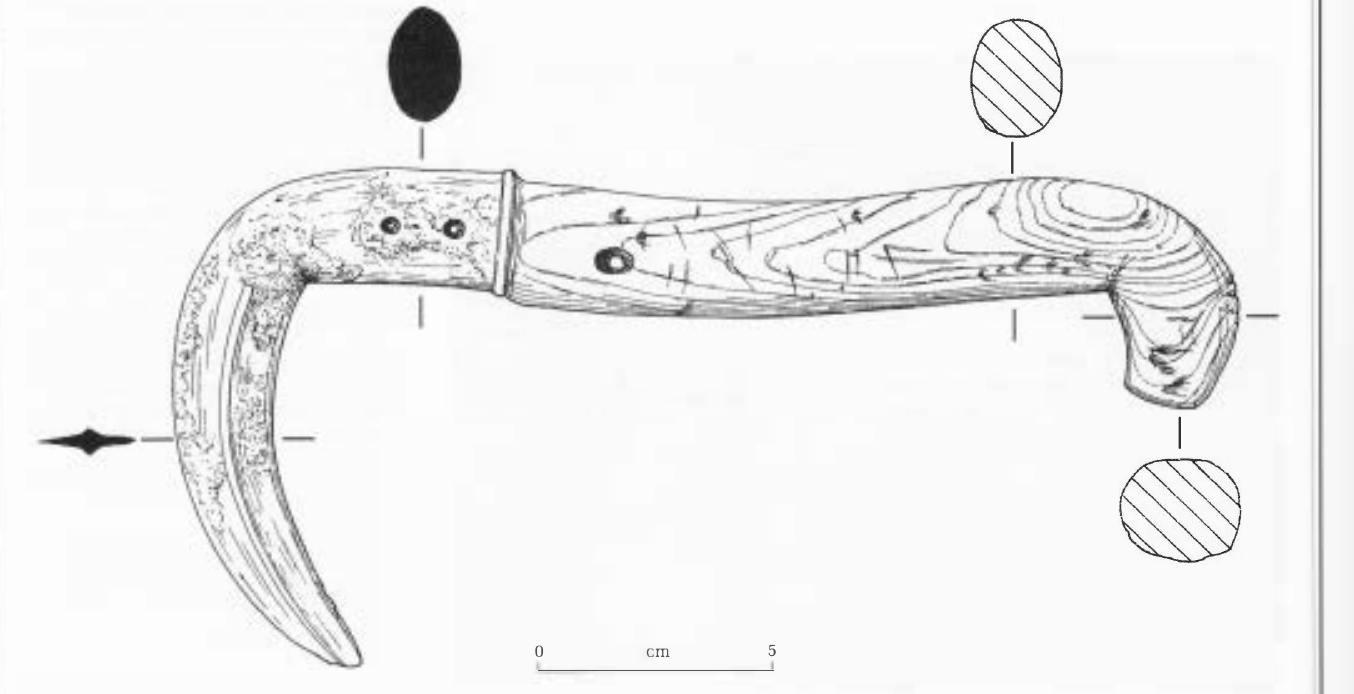
Figure 1 Scale drawing of the Late Bronze Age reed hook from East Sussex, with its wooden handle still attached to its metal